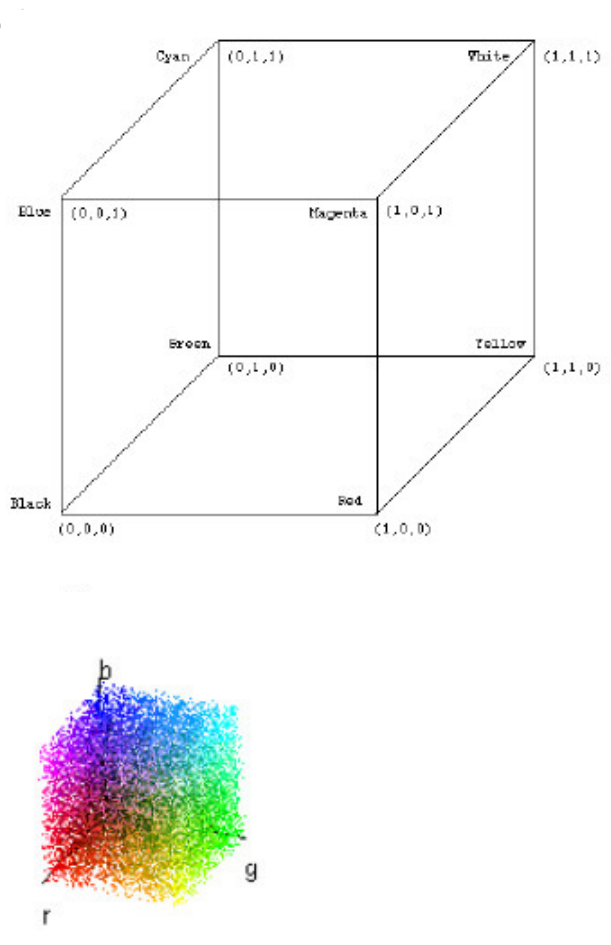
Figure 5: a ) A simplified view of a RGB colour cube and, b ) The RGB cube shown in colour from a different